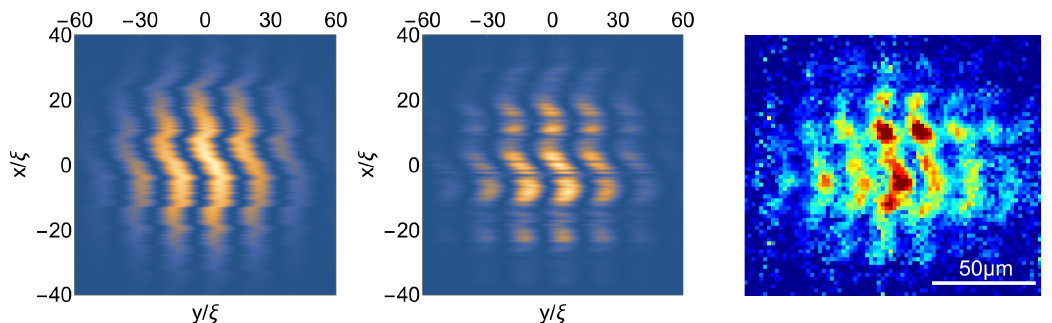
( (cid:126) r , t ) tof 1